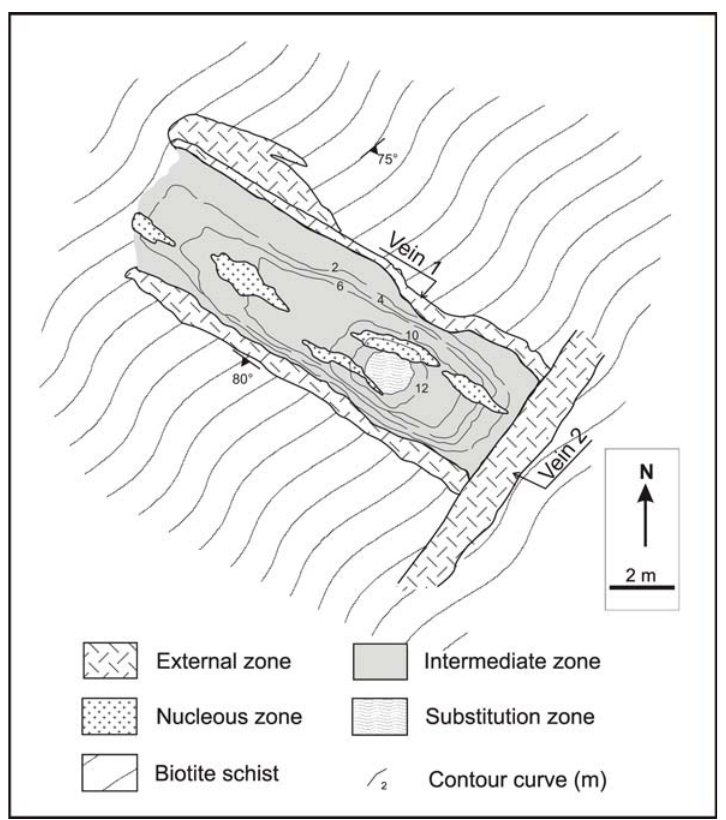
Fig. 2 – Geological sketch of the Alto Quixaba pegmatite showing its textural and mineralogical zonation (A.C.M. Ferreira, unpublished data). Descriptions of each zone are provided in the